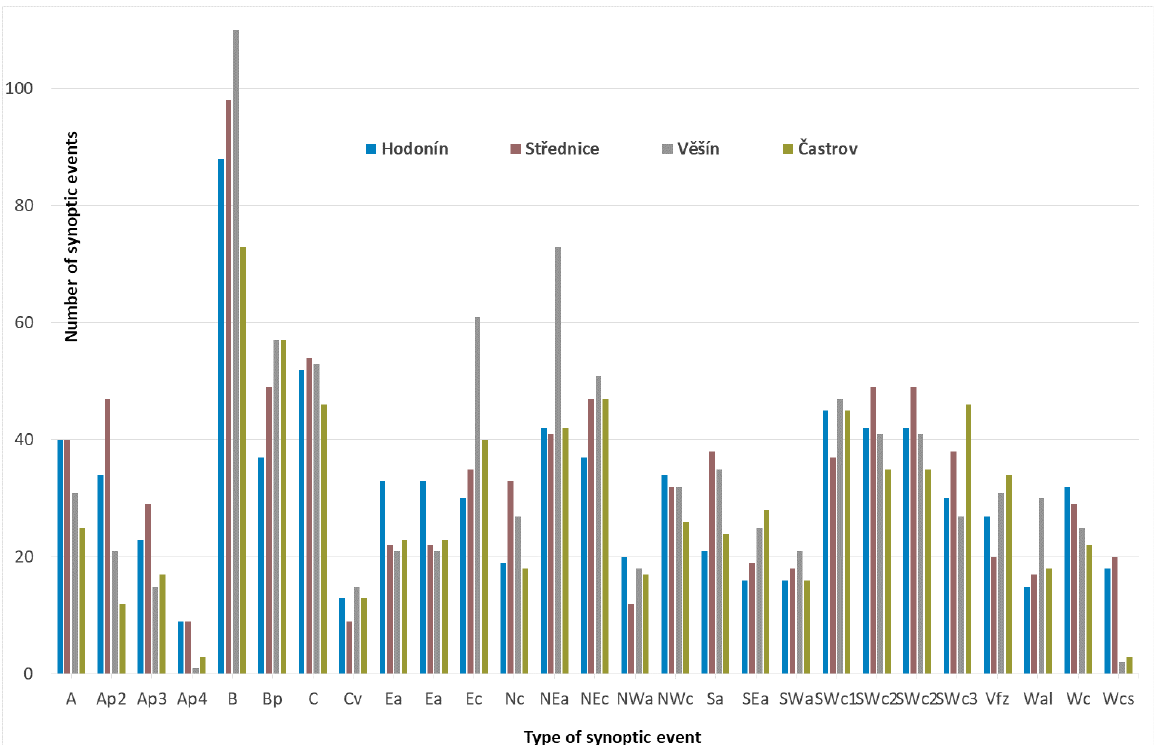
Figure 5. Frequency of synoptic events occurrence during the period of the cherry tree flowering (period of 1946 – 2012).